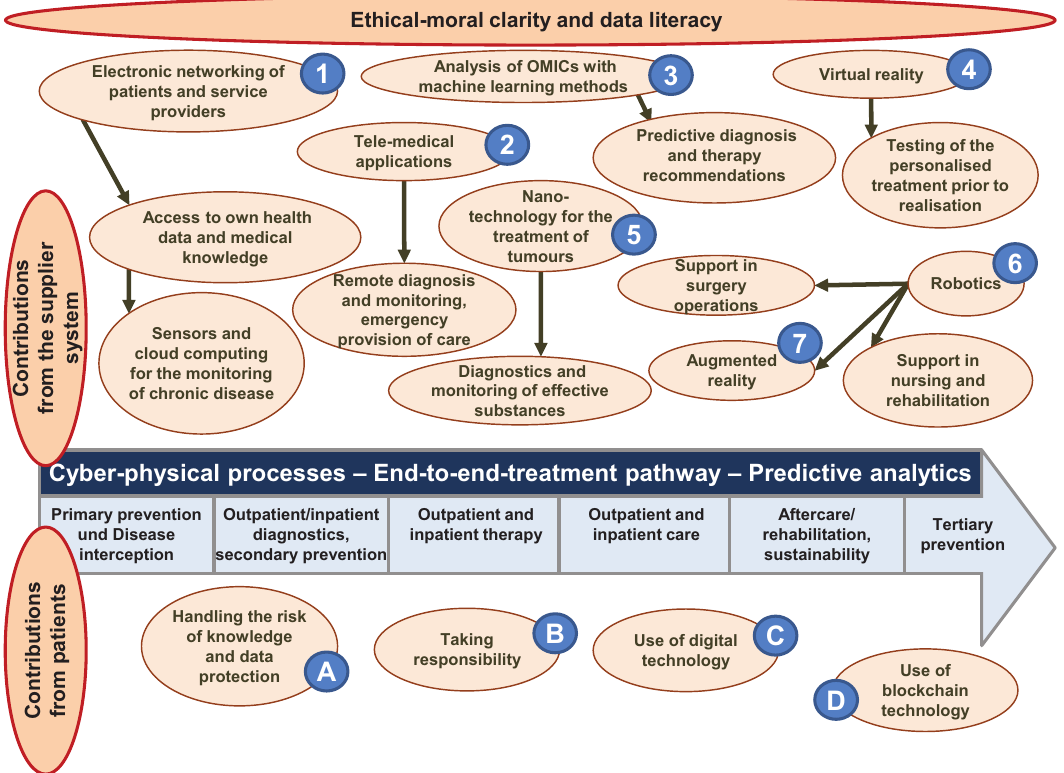
Figure 1. Examples for the potential of digital technologies for the personalisation of a treatment pathway 51